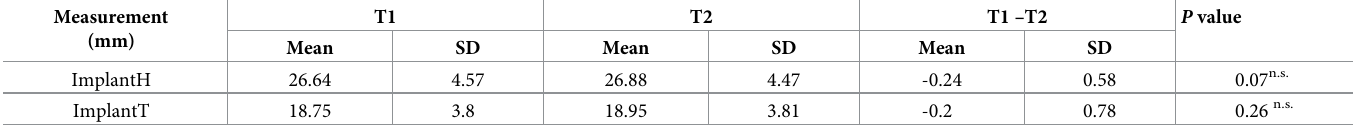
Table 1. Implant stability, determined by measuring the distances between the endpoints of two implants.